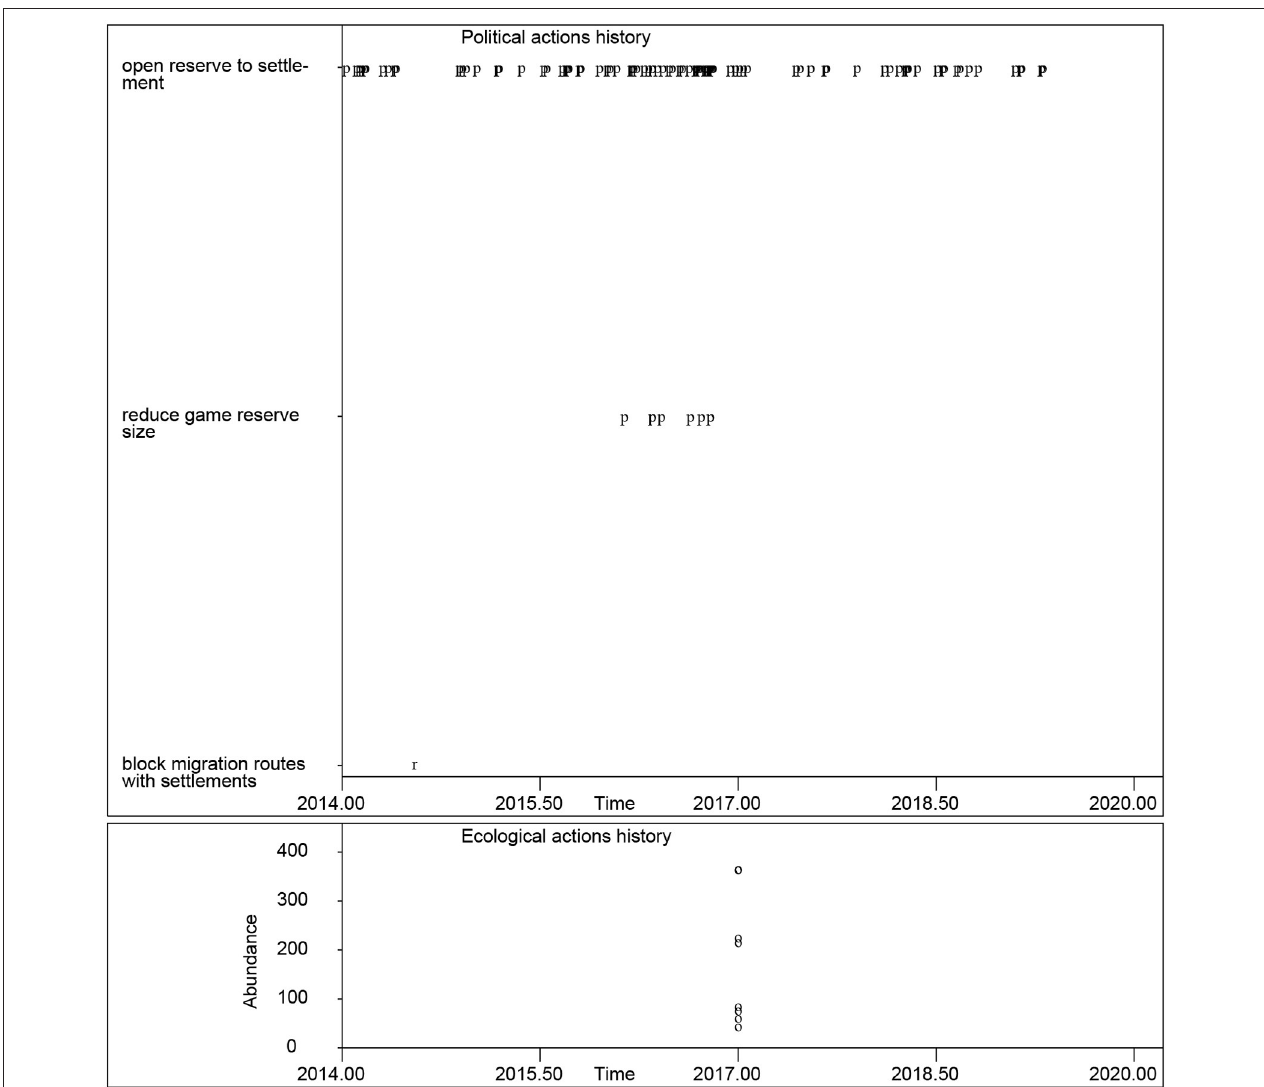
FIGURE 7 | Actions history of those actions that contribute to the destruction of cheetah habitat. See Figure 4 for the legend.